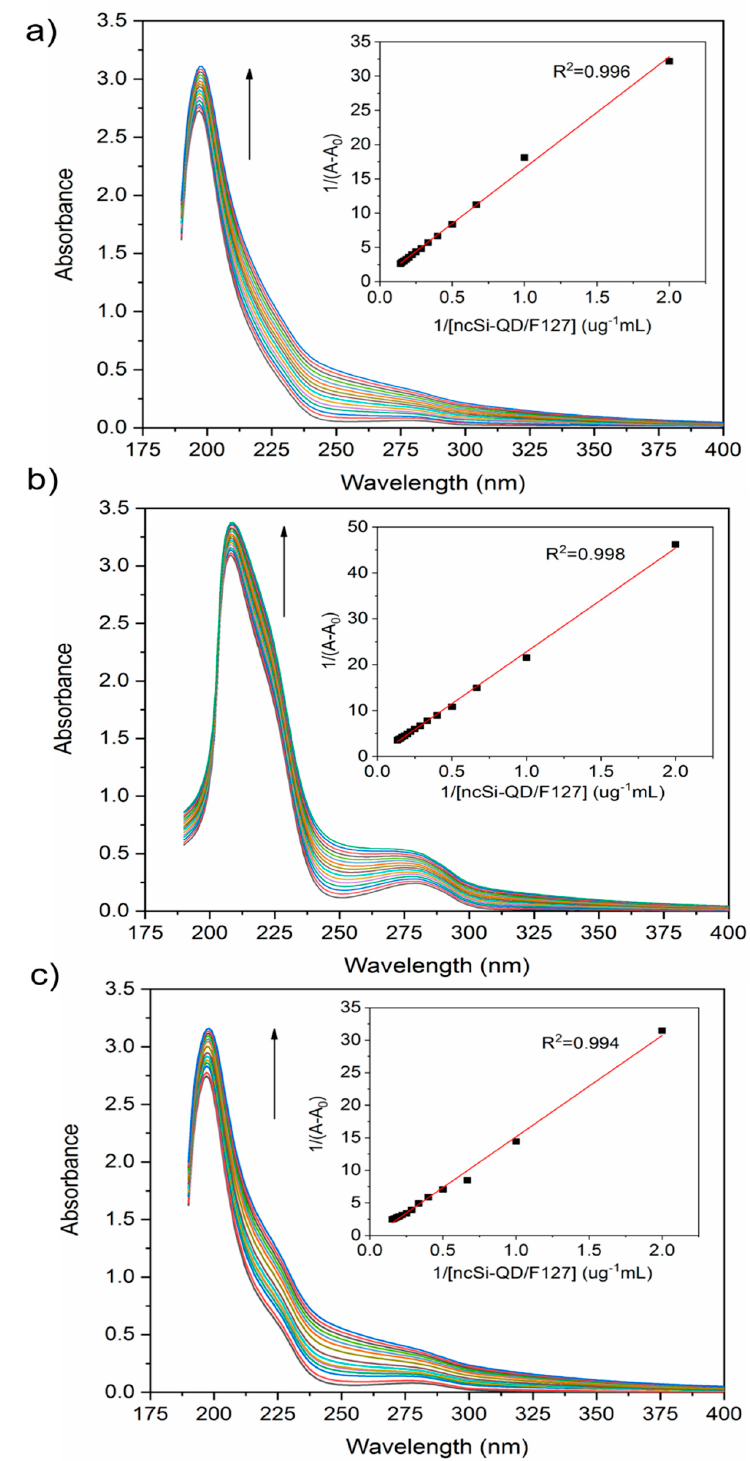
Figure 2. UV-visible absorption spectra of human serum albumin ( a ), fibrinogen ( b ), transferrin ( c ) with different concentrations (0–2.0 µg/mL) of SiQD-De/F127 nanoparticles and each proteins concentration are 1 µM. Optical absorbance increases continuously with the incremental addition of the nanoparticles. Insets show Benesi–Hildebrand plots for proteins as a function of nanoparticle concentration.